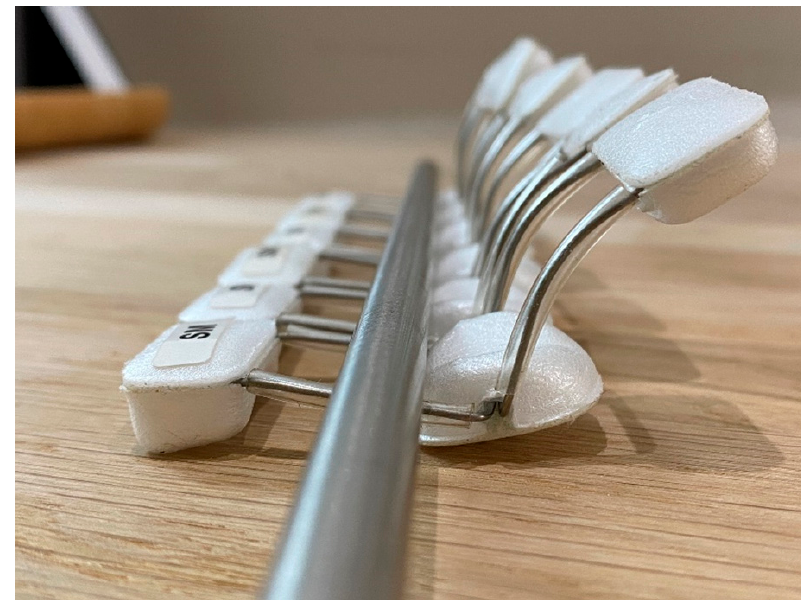
Figure 4. LMB 501 orthoses.